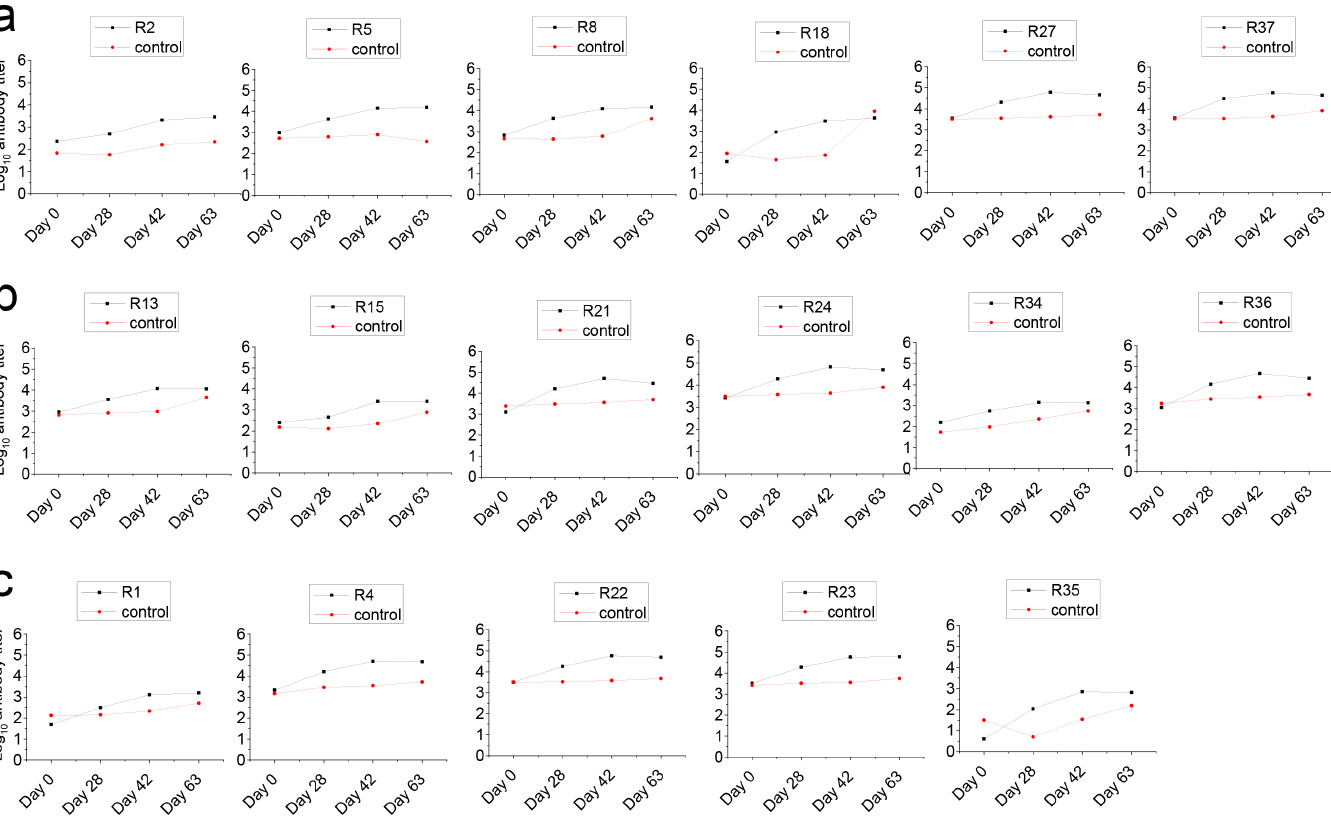
Fig 1. Serum antibody titers to antigens. ( 1a ) Serum antibody titers to antigens in group B (R2, R5, R8, R18, R27, R37) shown in black. ( 1b ) Serum polyclonal antibody titers to antigens in group C (R13, R15, R21, R24, R34, R36) shown in black. ( 1c ) Serum polyclonal antibody titers to antigens in group D (R1, R4, R22, R23, R35) shown in black. Median values for serum antibody titers shown on Y axis of samples taken prior to vaccination (day 0), at the time of boost (day 28), immediately prior to H . somni bacterial challenge (day 42) and immediately prior to euthanization (day 63). “ R ” is denoted for rank of gene or protein. Group A, the control group, only received Emulsigen supplemented with CpG is shown in